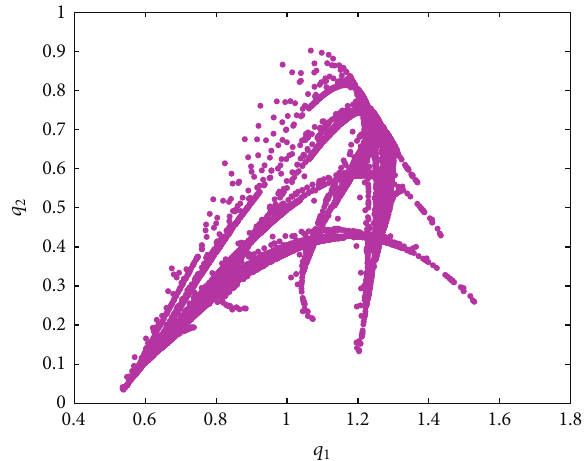
Figure 8: Chaos attractors of system (6) for 𝛼 1 = 1.32 and 𝛼 2 = 2.471